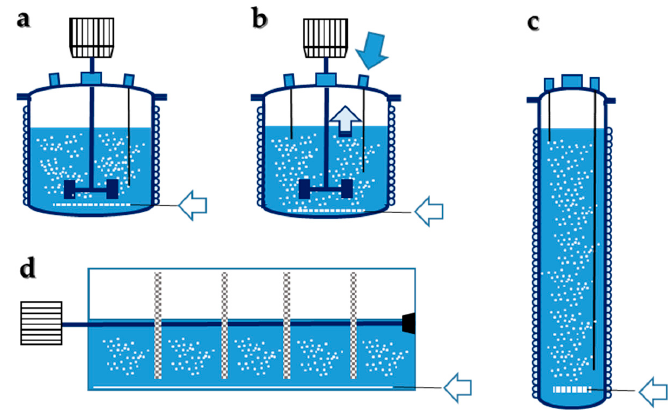
Figure 4. Different types of bioreactors for fumaric acid production: ( a ) Stirred tank -batch operation; ( b ) Stirred tank–fed-batch operation; ( c ) bubble-column reactor; ( d ) Rotary biofilm contactor.